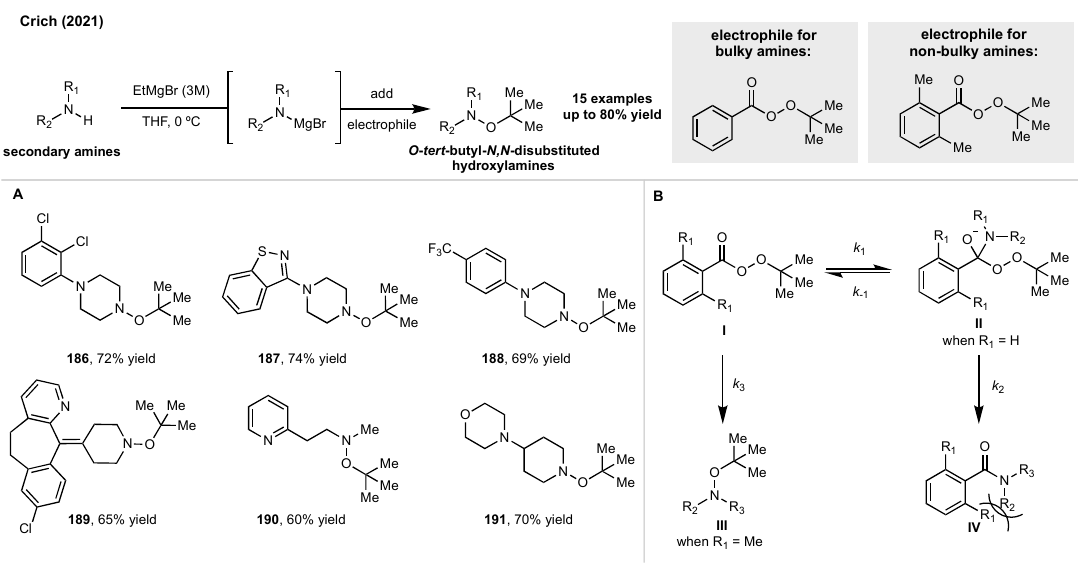
Scheme 18. Crich’s synthesis of trisubstituted hydroxylamines by direct N-O bond formation. ( A ) Selected examples of the reaction. ( B ) Application of direct N-O bond formation to a shortened formal synthesis of a hydroxylamine analog of the marine natural product, kalkitoxin [87,92].